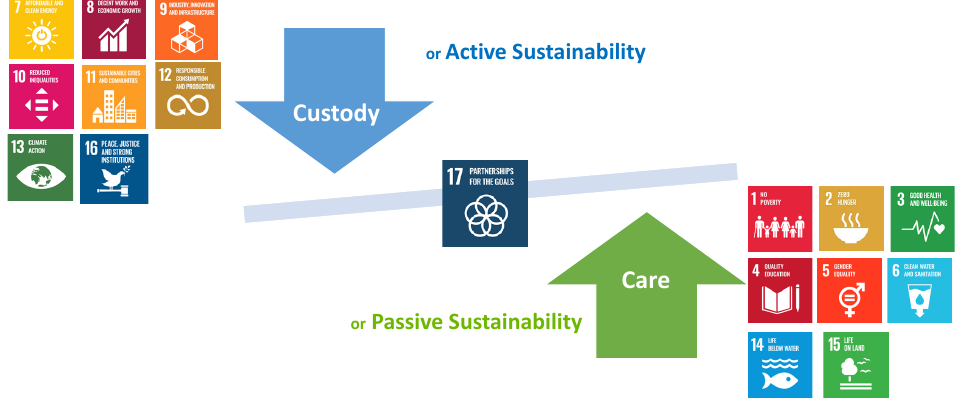
Figure 1. Active and Passive Sustainability.